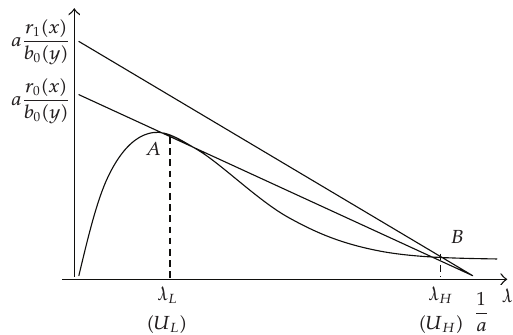
Figure 3: From low to high unemployment